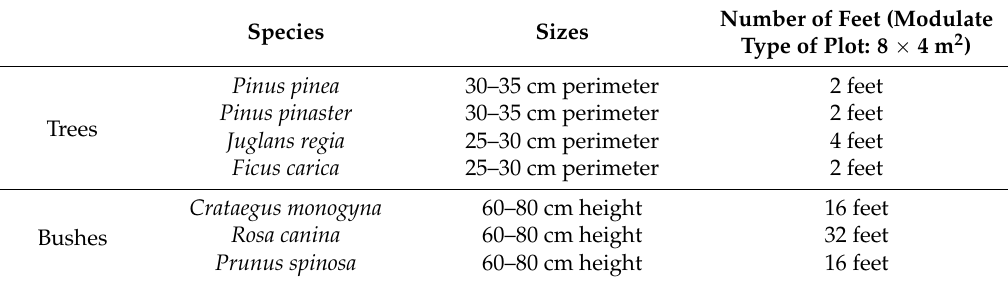
Table 10. Species for agroforestry plots in Zone